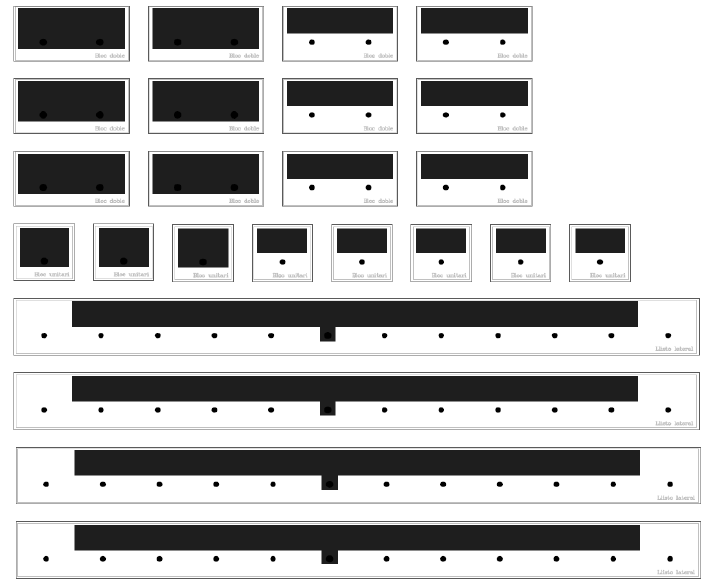
Figure 1. Plan of the test bank.